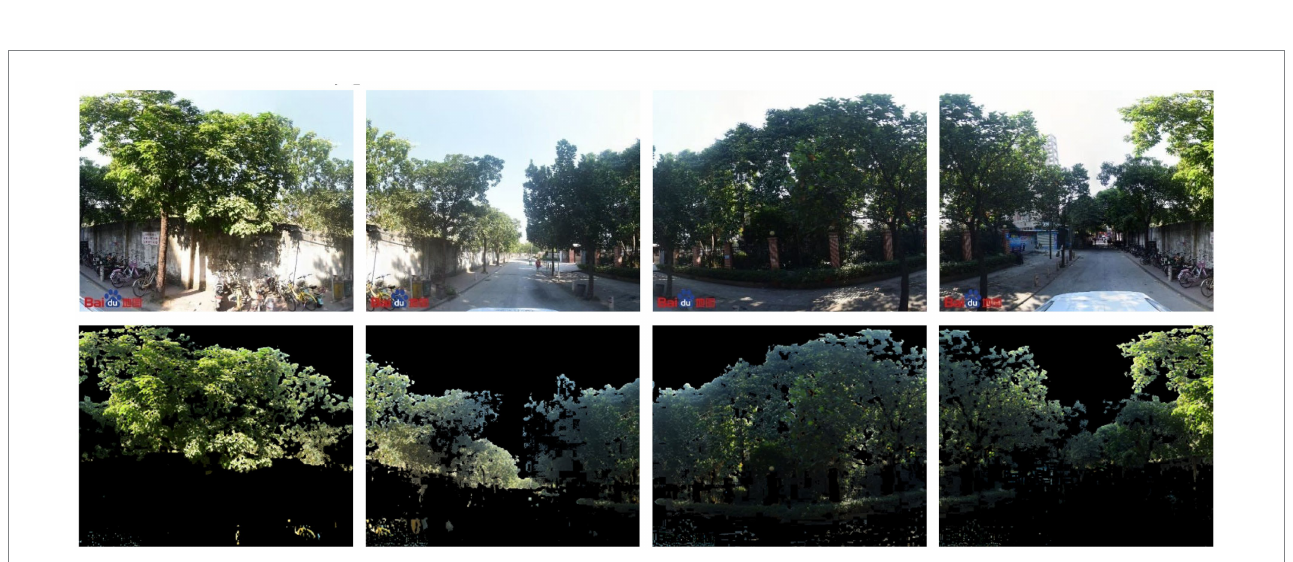
FIGURE 2 A random forest technique example.